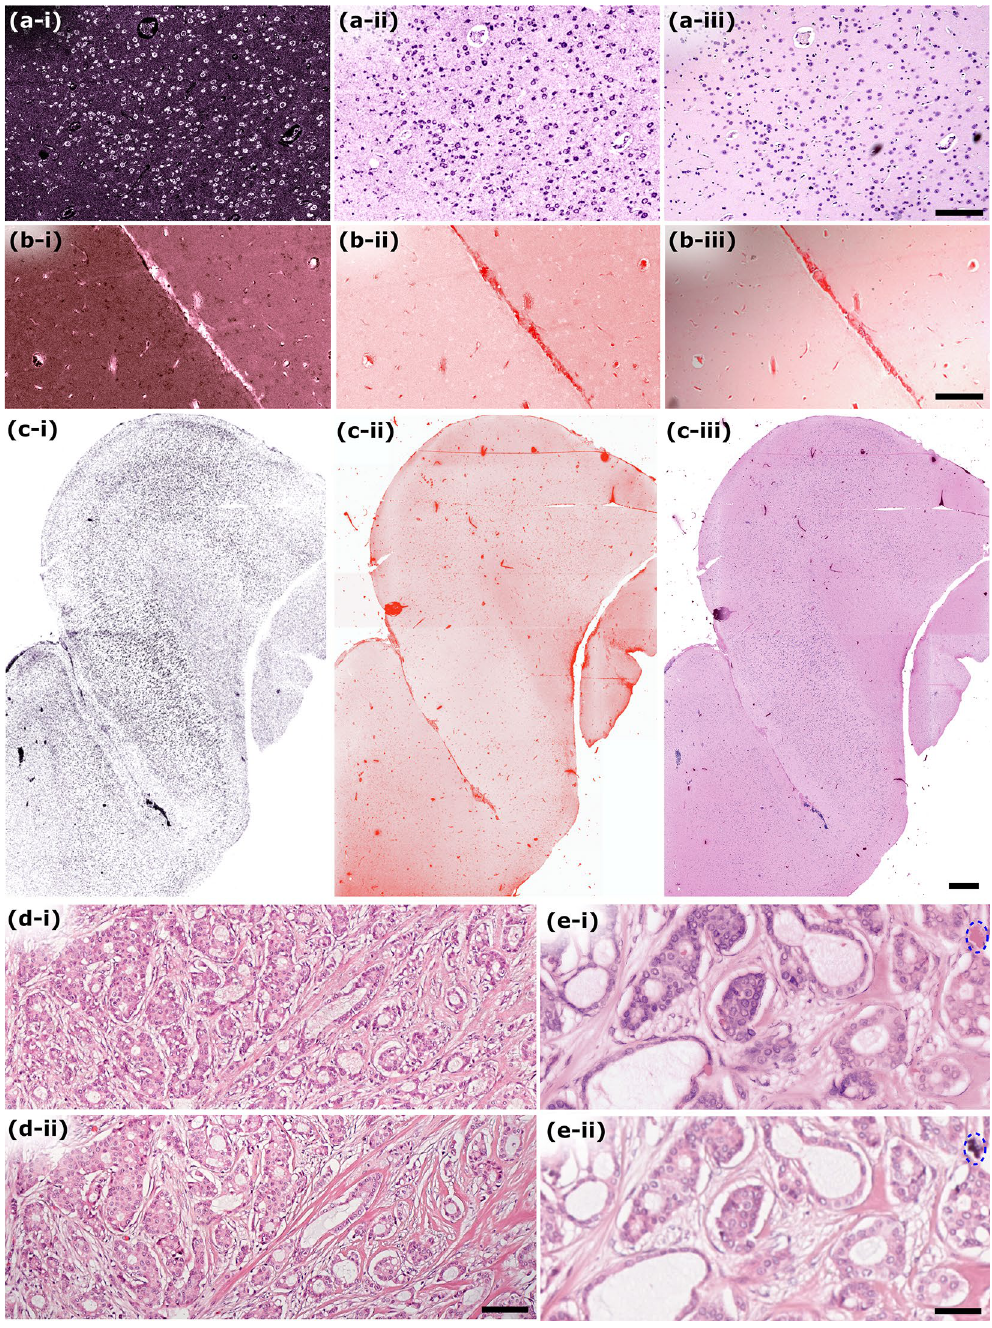
Figure 5. Comparison of the SG-PARS radiative and non-radiative absorption contrast with traditional histochemical stains. ( a ) Comparison of TA-PARS 266 nm non-radiative absorption contrast with hematoxylin staining. ( a-i ) TA-PARS 266 nm non-radiative absorption contrast highlighting predominately nuclear structures. ( a-ii ) False colored version of image presented in ( a-i ). ( a-iii ) Same section of tissue stained with hematoxylin stain only providing a one-to-one comparison with non-radiative TA-PARS. Scale Bar: 200 µm. ( b ) Comparison of TA-PARS 266 nm radiative absorption contrast with eosin staining. ( b-i ) TA-PARS 266 nm radiative absorption contrast highlighting predominately extra-nuclear structures (i.e., collagen, elastin, NADPH). ( b-ii ) False colored version of image presented in ( b-i ). ( b-iii ) Same section of tissue stained with eosin stain only providing a one-to-one comparison with radiative TA-PARS. Scale Bar: 200 µm. ( c ) TA-PARS image of nearly an entire section of resected brain tissues. ( c-i ) Non-radiative absorption contrast of predominately nuclear structures. ( c-ii ) Radiative absorption contrast of predominately extra-nuclear structures. ( c-iii ) TA-PARS emulated H&E image of nearly the entire section of resected brain tissues with analogous contrast to traditional H&E staining. Scale Bar: 1 mm. ( d , e ) One-to-one comparison between standard brightfield H&E preparations (i) and TA-PARS emulated H&E images (ii) in thin sections of human lymph node containing breast cancer. Note: An artifact attributed to dust particulate is circled in blue ( e ). ( d ) Scale Bar: 100 µm. ( e ) Scale Bar: 50